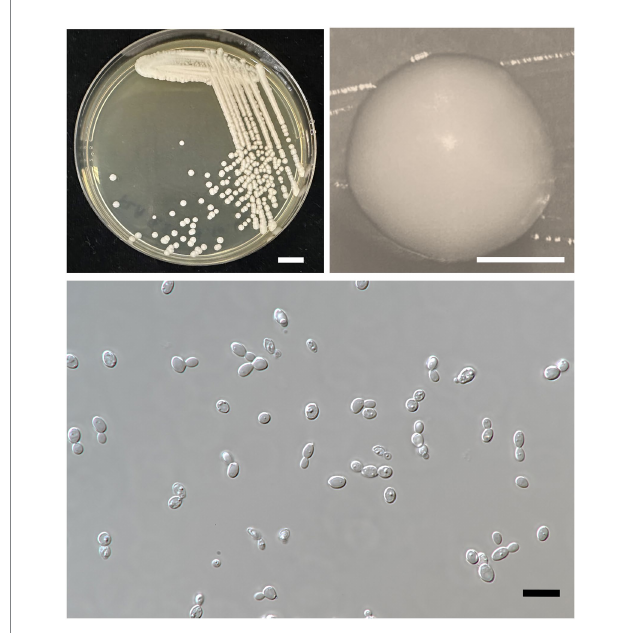
FIGURE 6 Wickerhamiella thailandensis FLA4.2 T (=SDBR-CMU432 T , holotype). Culture (A) , single colony (B) , and cells (C) on YMA after incubation at 25 ° C for 3 days. Scale bar A = 1 cm, B = 1 mm, and C = 10 μ